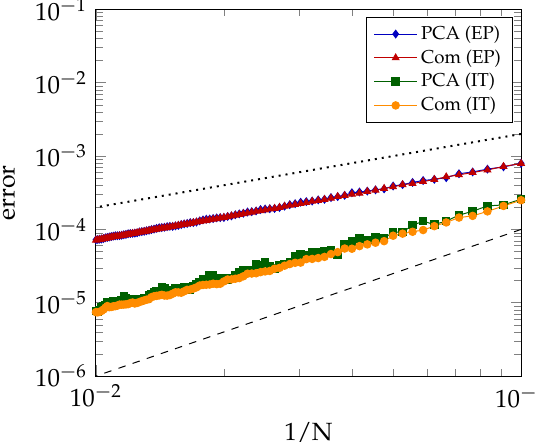
Figure 1. Error with respect to the semidiscrete values for r u p S 0 , T q and u app p S 0 , T q if m “ 100. Two reference lines included for first-order convergence (dotted) and second-order convergence (dashed).